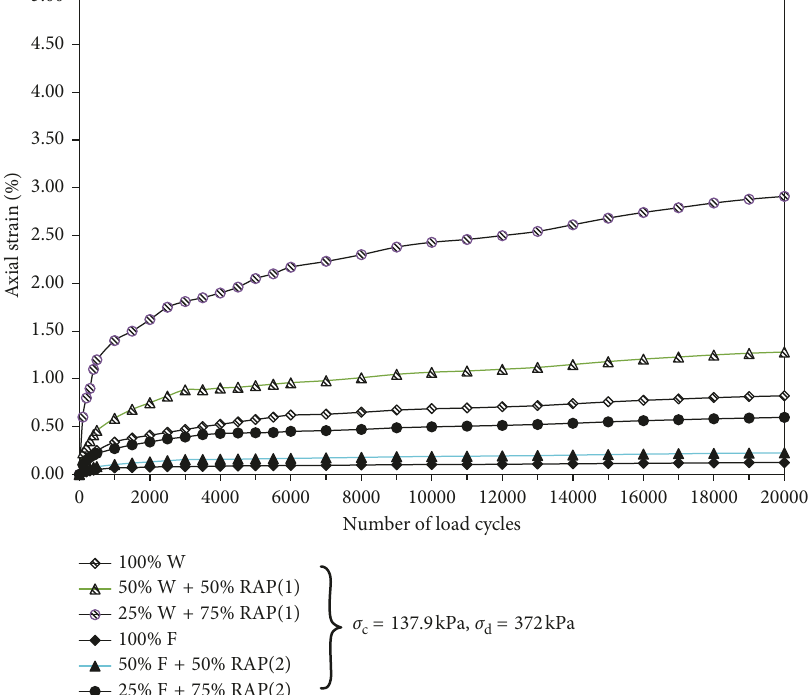
Figure 12: Effect of RAP contents on residual strain under long-term repeated loading.